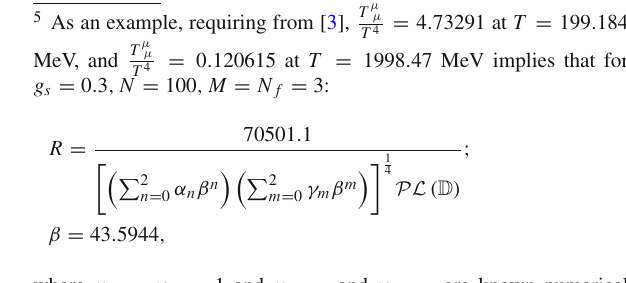
μ μ = 4 . 73291 at T = 199 . T 4